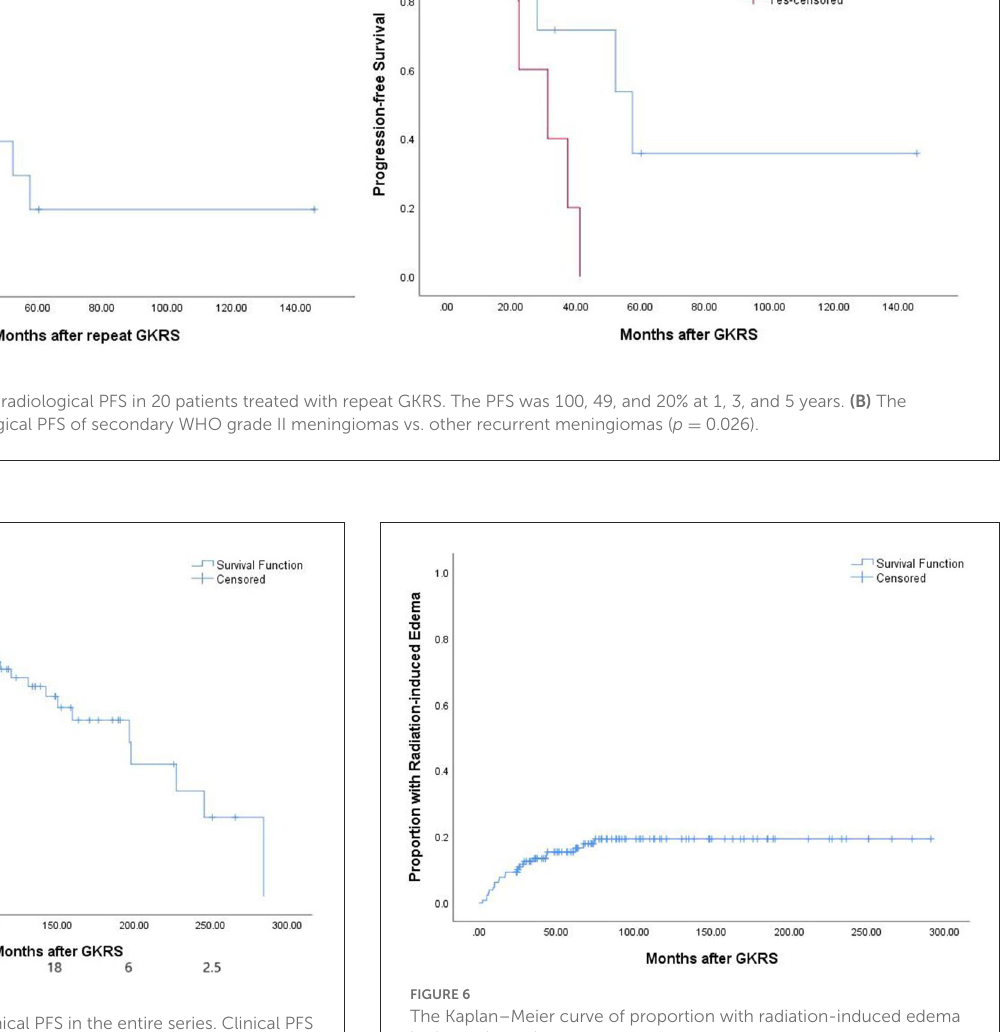
of 424 patients experienced initial symptom aggravation,